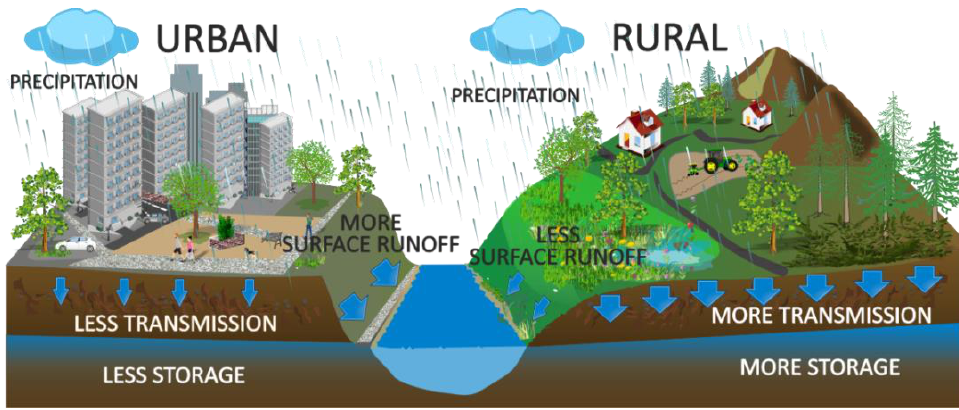
Figure 2. Illustration representing hydrological processes examined in urban and rural catchments.